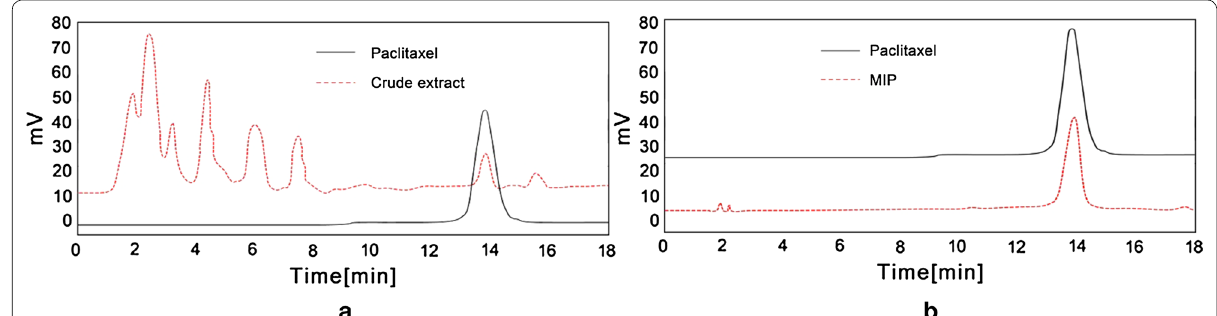
Fig. 1 HPLC diagram of paclitaxel from the fermentation broth ( a paclitaxel standard and crude extract, b paclitaxel standard and MIPs)